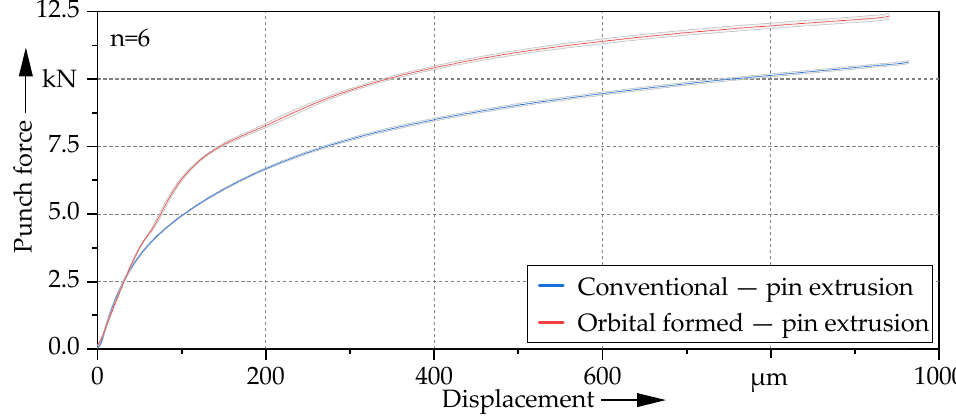
Figure 7. Comparison of the force–displacement curves of the pin extrusion for the conventional samples and the samples with material distribution.